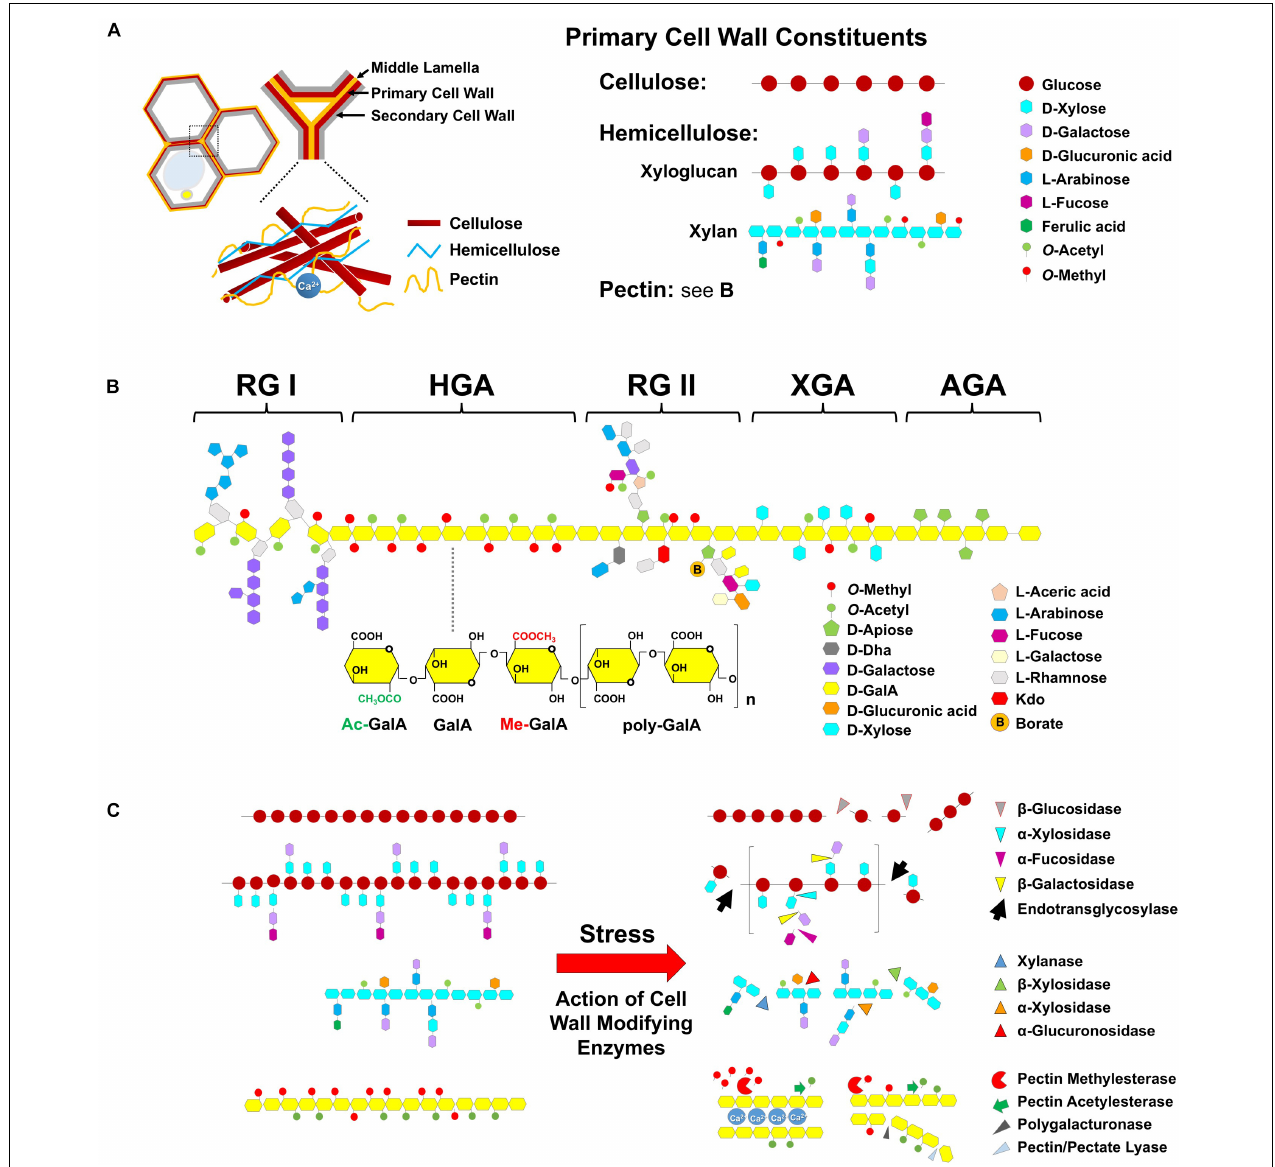
FIGURE 3 | Cell wall composition and enzymatic modification in response to heat. (A) The cell wall is a complex structure that is composed of cellulose and non-cellulosic neutral polysaccharides embedded in a pectin matrix. Pectins are located in the middle lamella and primary and secondary cell wall. Major primary cell wall are constituted of cellulose microfibrils (multiple chains of β -glucose with β -1,4 glycosidic bonds) which are cross-linked to hemicelluloses and to pectin. Xyloglucan is a major hemicellulose molecule that is composed of β -1,4-linked glucose residues with α -1,6-linked xylosyl side chains. In turn, these side chains can be decorated with either galactose, or fucose residues to create a complex pattern of branches. Xylan consists a backbone of β -1,4-linked xylose (Xyl) residues that can be substituted with glucuronic acid and/or arabinose. Additional substitutions such as acetyl and methyl groups can be also presented. And (B) pectins are highly complex class of polysaccharides that comprise galacturonic acid-rich, consisting of five major classes, namely: homogalacturonan (HGA), rhamnogalacturonan I (RG-I), rhamnogalacturonan II (RG-II), xylogalacturonan (XGA), and apiogalacturonan (AGA) form a structurally diverse glue which provides stiffness or flexibility relying on the chemical modification. (C) Based on the action of hydrolysis and substrate specificity, the degradation of cellulose is cleaved by β -glucosidase into two molecules of glucose; for breaking down hemicellulose, xyloglucan endotransglycosylase/hydrolase (XTH), and expansin proteins (not shown) associated with disassembly of cellulose and xyloglucan matrix may play a role in the cell wall remodeling in different aspects of plant development and stress responses. Xylanase is responsible for degrading xylan by cleaving β -1,4 xylose linkages in the backbone. β -xylosidases cleave xylose from the non-reducing end of the xylan chain, and glucuronidases cleave the α -1,2 linked glucuronic acid, and α -arabinosidases cleave the α -1,2 and α -1,3 linked arabinose from the backbone. Pectinolytic enzymes such as PME, PAE, PG, PL, and Arabinanase by hydrolysis of pectic substances, are important for cell wall remodeling. The HGA, a polysaccharide of α -1,4-linked galacturonic acid (GalA) residues, is the predominant form of pectin. A critical feature of HGA that influences its properties is the methyl-esterification and acetylation of specific carbons on GalA during synthesis of the backbone. HGA is de-methylesterified by the activity of PME, which results in random and contiguous patterns of free carboxylic residues. De-methyl-esterification randomly releases protons, which become a target for pectin-degrading enzymes such as PG, which act by hydrolyzing the α -1,4 link between GalA. The contiguous de-methylesterified HGA binds with Ca 2 + to induce gel formation, which can rigidify the cell